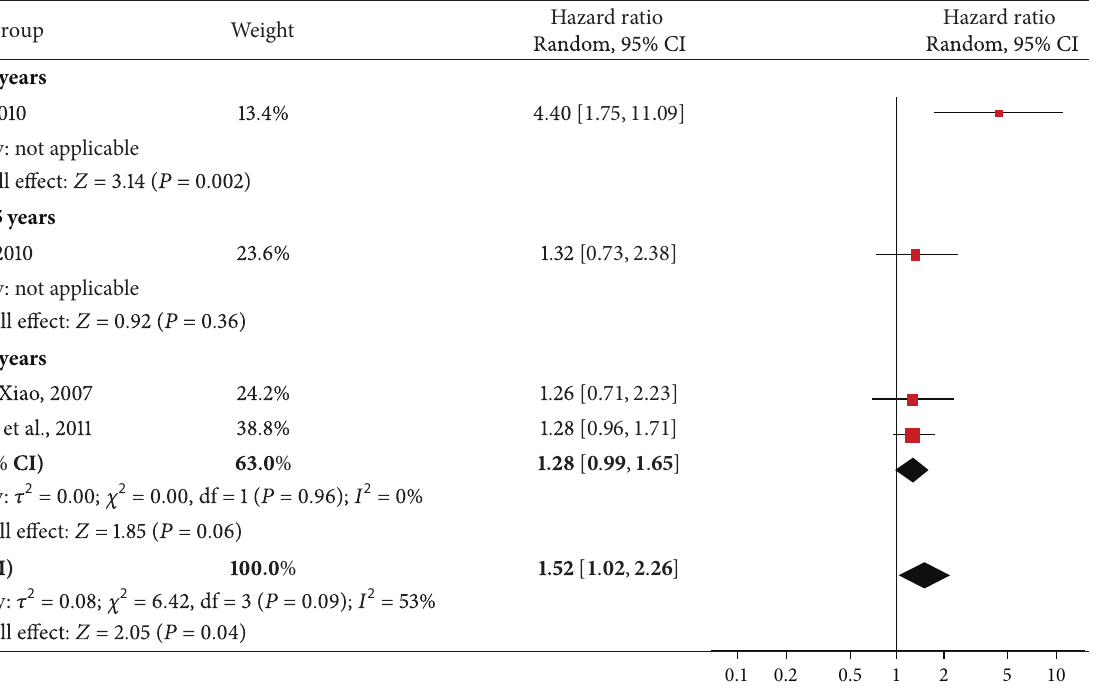
Figure 4: HR of mortality among subjects with depression after